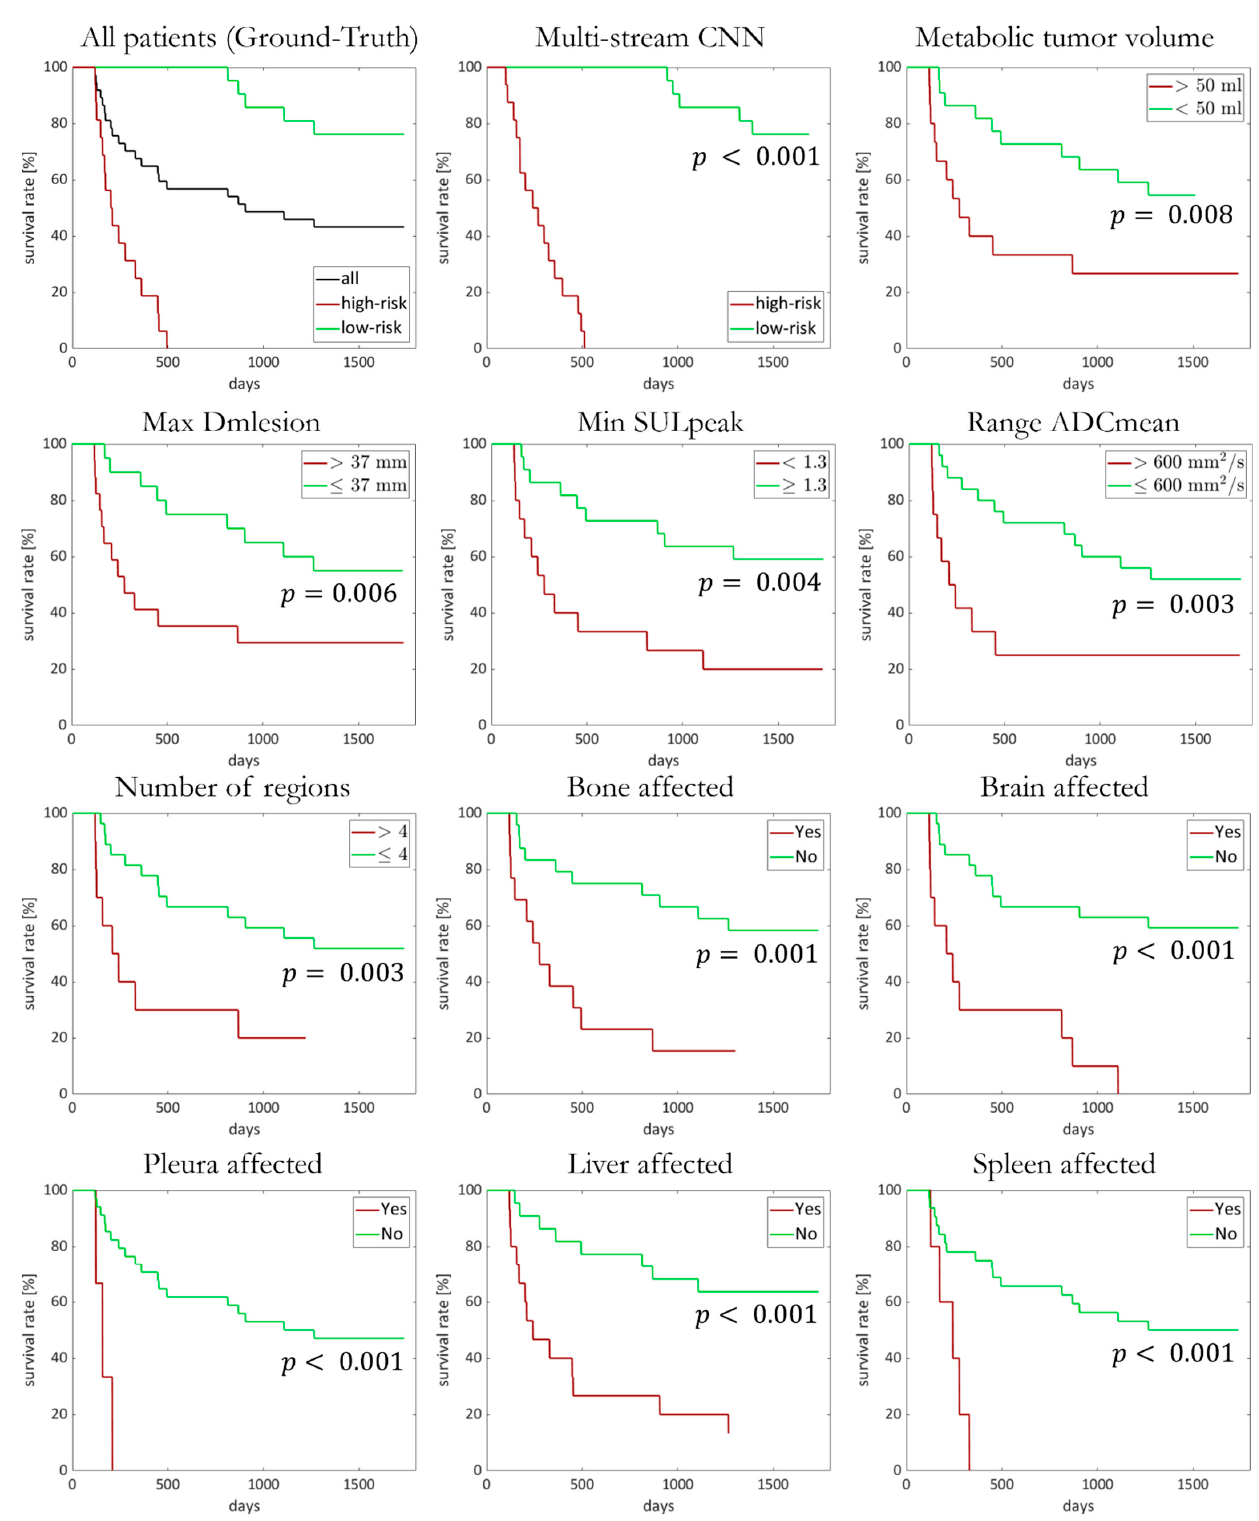
Figure 4. Kaplan–Meier plot for overall-survival analysis since start of systemic treatment for all patients depending on metabolic tumor volume, max. lesion diameter (Dmlesion), min. peak standardized uptake value (SULpeak), range of mean apparent diffusion coefficient (ADCmean), number of affected regions and respective affected regions, as well as estimated values obtained from multistream